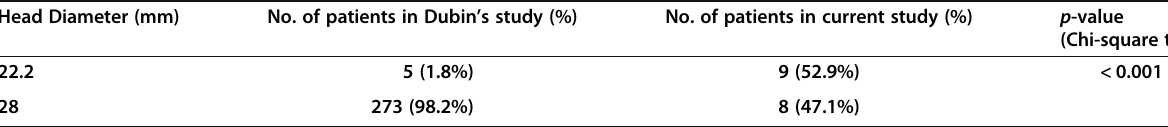
Table 3 Diameter of femoral head used in MDM in Dublin ’ s study and in current study Head Diameter